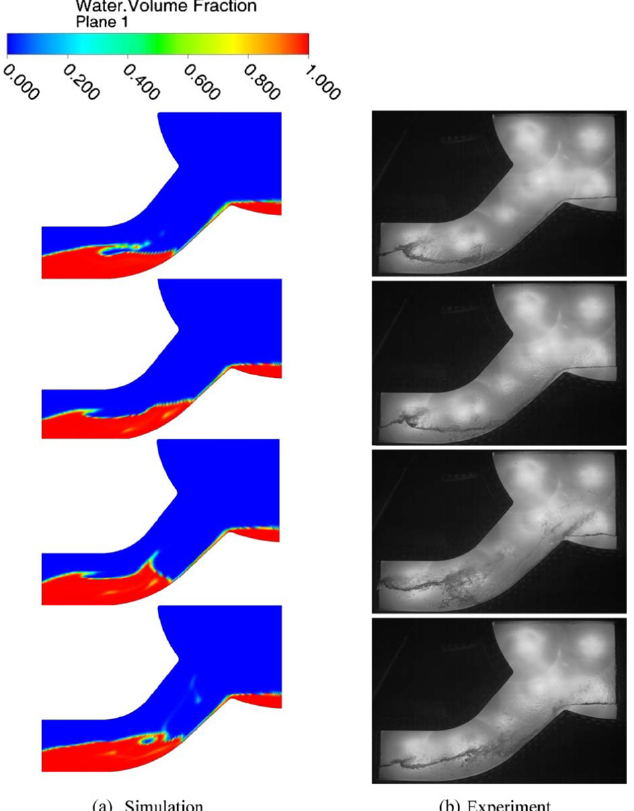
Figure 19. Flow structure of the steam–water counter-current flow near the elbow around flooding ( Q G = 0.530 kg/s); ( a ) calculated water volume fraction and ( b ) visual observation obtained from experiment (Deendarlianto et al.